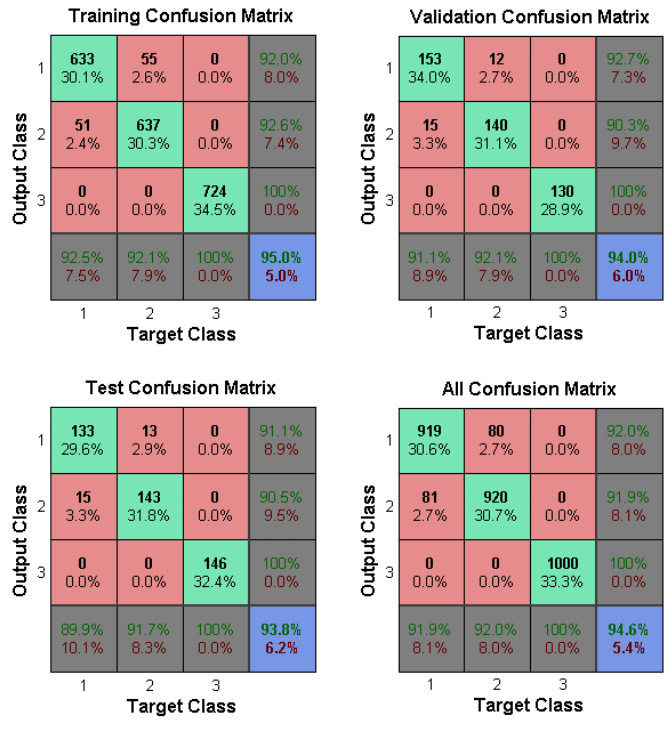
Figure 4. Confusion matrix for classification of miscible